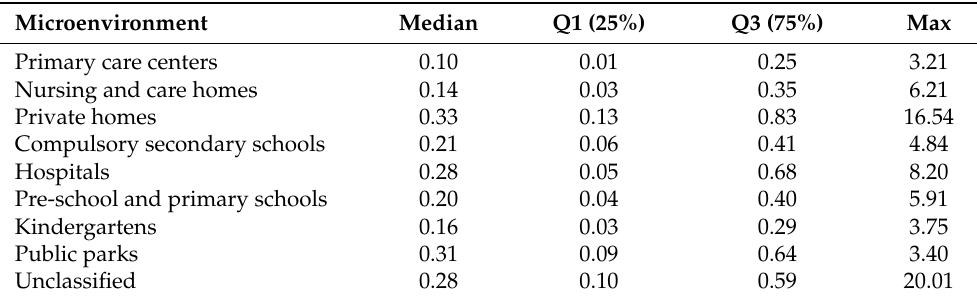
Table 2. Descriptive statistics parameters (median, 25th, and 75th percentiles and maximum) for the E (V/m) values measured in various microenvironments in Catalonia (Spain).